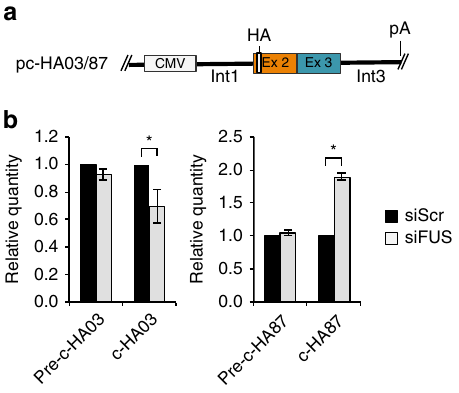
Figure 5 | Artificial constructs reproduce FUS-dependent back-splicing. ( a ) Schematic representation of the pc-HA-c03 and pc-HA-c87 constructs. The second and third exons were cloned into pc-DNA3.1 þ vector together with B 1,500 nucleotides of the flanking introns. An HA tag was inserted in order to discriminate the ectopically expressed circRNAs from the endogenous ones. ( b ) Histograms show the circRNA levels derived from pc-HA03 and pc-HA87 together with the corresponding linear transcripts (pre-c-HA03 and pre-c-HA87) in N2a cells treated with control siRNAs (siScr; black bars) or with siRNAs against FUS (siFUS; grey bars). The values were normalized against Neomycin mRNA levels and expressed as relative quantity with respect to siScr samples set to a value of 1. For all the experiments shown in the figure, error bars represent s.e.m. of three independent experiments. * P o 0.05 corresponds to two-tailed Student’s t